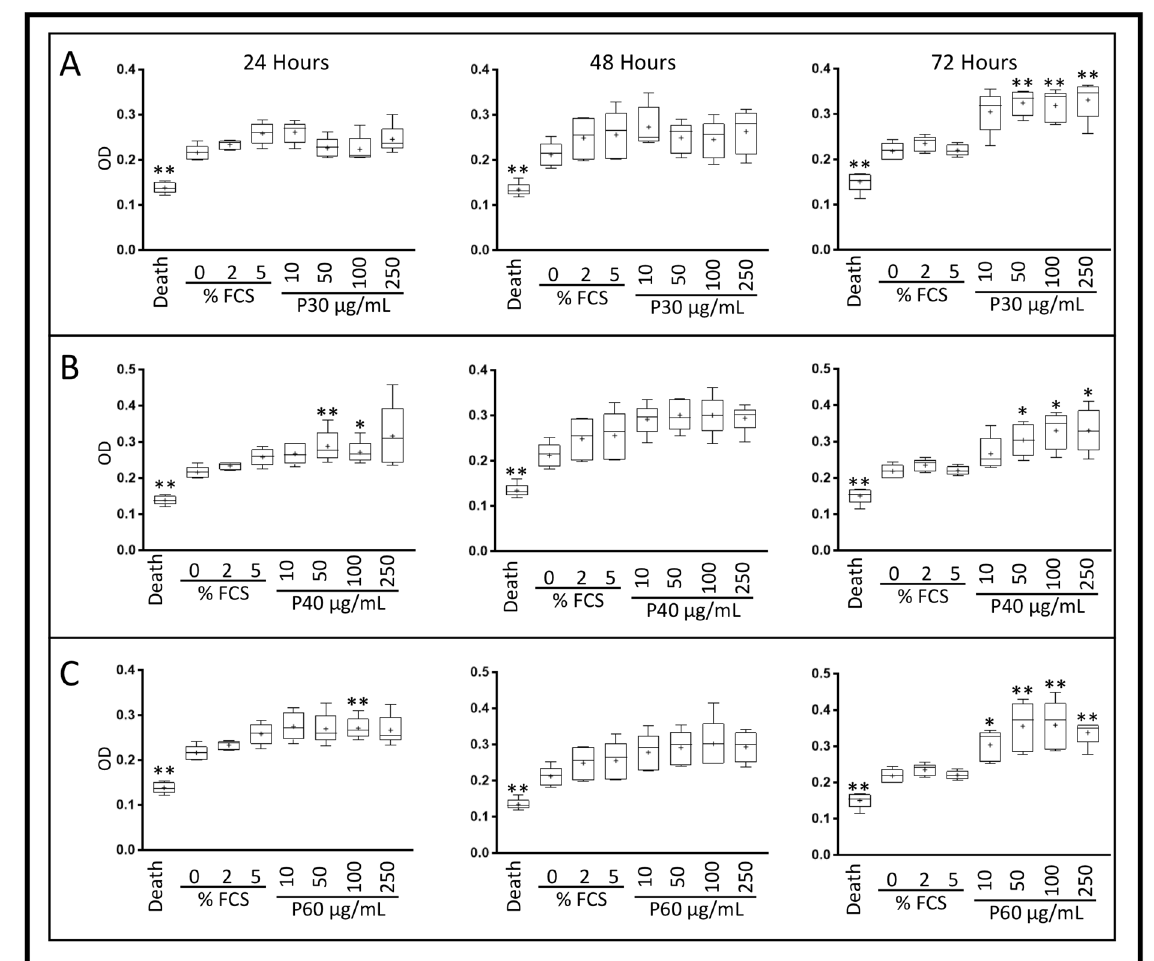
Figure 5. Effect of high concentrations of Promerim ® 30, 40, and 60 on the mitochondrial activity of equine articular chondrocytes cultured in the presence of 2% fetal calf serum (FCS). Equine articular chondrocytes were amplified and seeded at P3. At 80% of confluency, the cells were treated with Promerim ® 30 ( A ), 40 ( B ), 60 ( C ) at several concentrations (10, 50, 100, 250 µg/mL) in the presence of 2% of FCS and then cultured for 24, 48 and 72 h in hypoxia. Controls with 0%, 2% and 5% of FCS, and a death control (triton-induced death) were included. The levels of formazan were measured (OD) in the media at the end of the culture period (XTT kit, Roche). Data are represented as box plots ( n = 5). Statistical analyses were based on the Mann–Whitney test (* p < 0.05; ** p < 0.01) and the 2% FCS condition was used as a reference. P30, P40 and P60: Promerim ® 30, Promerim ® 40, and Promerim ® 60.